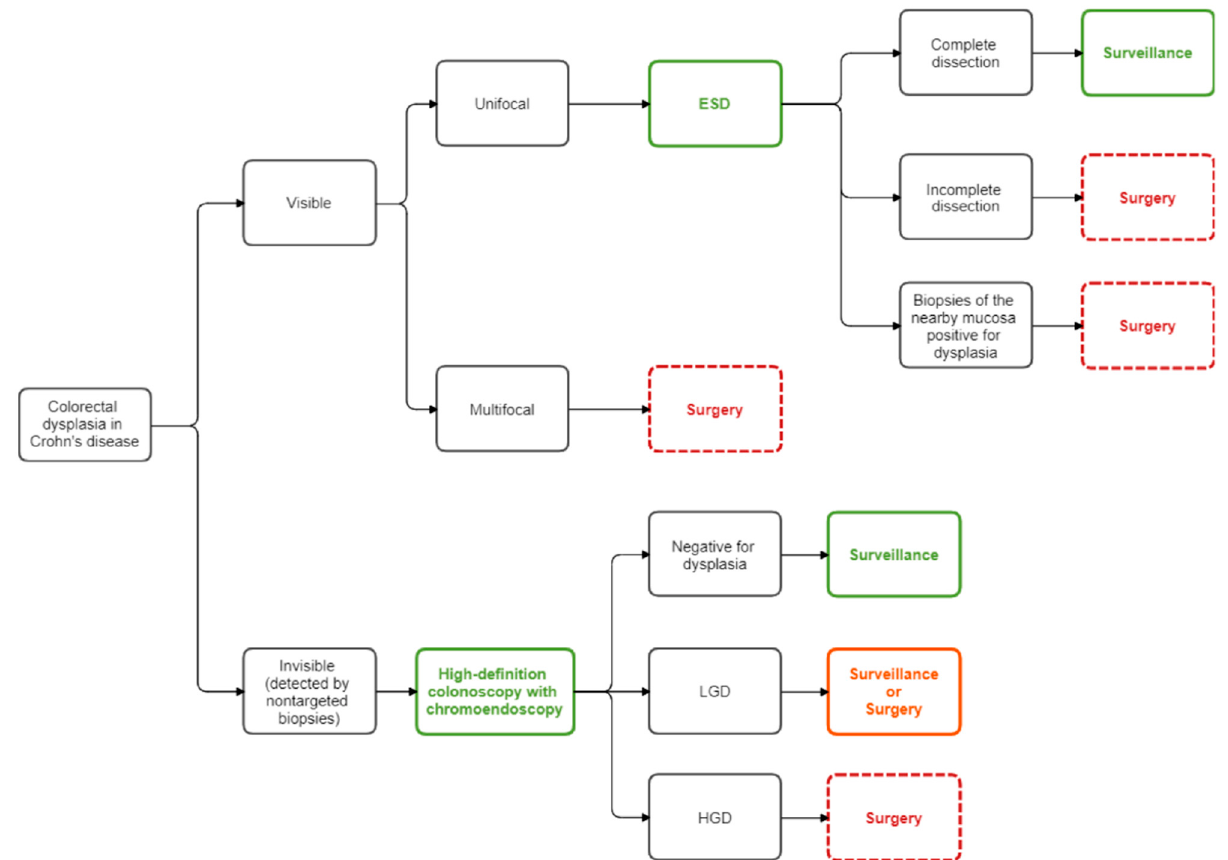
Figure 4. Flow diagram for the management of colorectal dysplasia in Crohn’s disease. ESD: endoscopic submucosal dis- section; HGD: high-grade dysplasia; LGD: low-grade dysplasia.